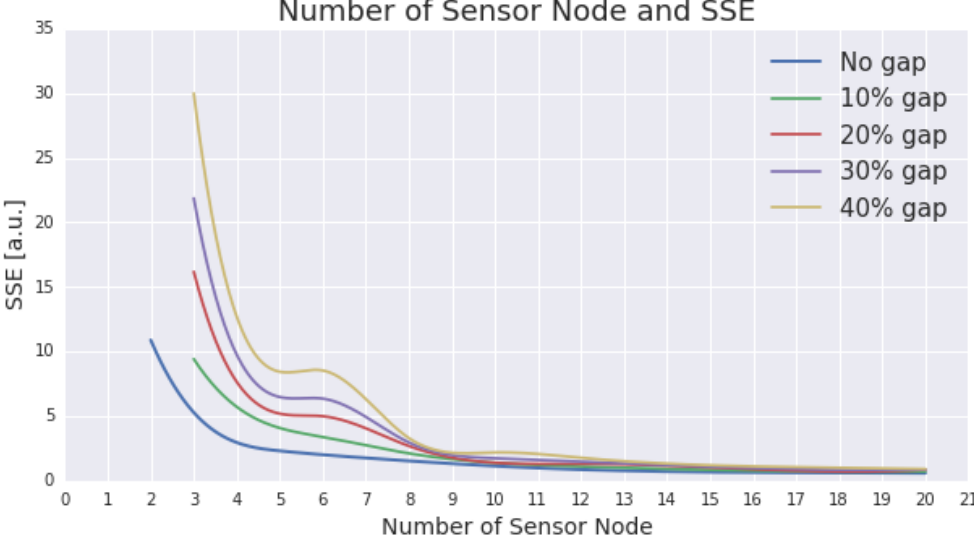
Figure 6. The figure presents the impact of certain degree of gaps to the performance of the proposed ESN design (sensor nodes placement). The gaps are set within the range of 10%, 20%, 30%, and 40% (illustrated by green, red, purple, and yellow lines, respectively). For comparison purposes, the performance of the ESN design without gap is also presented (using a blue line).